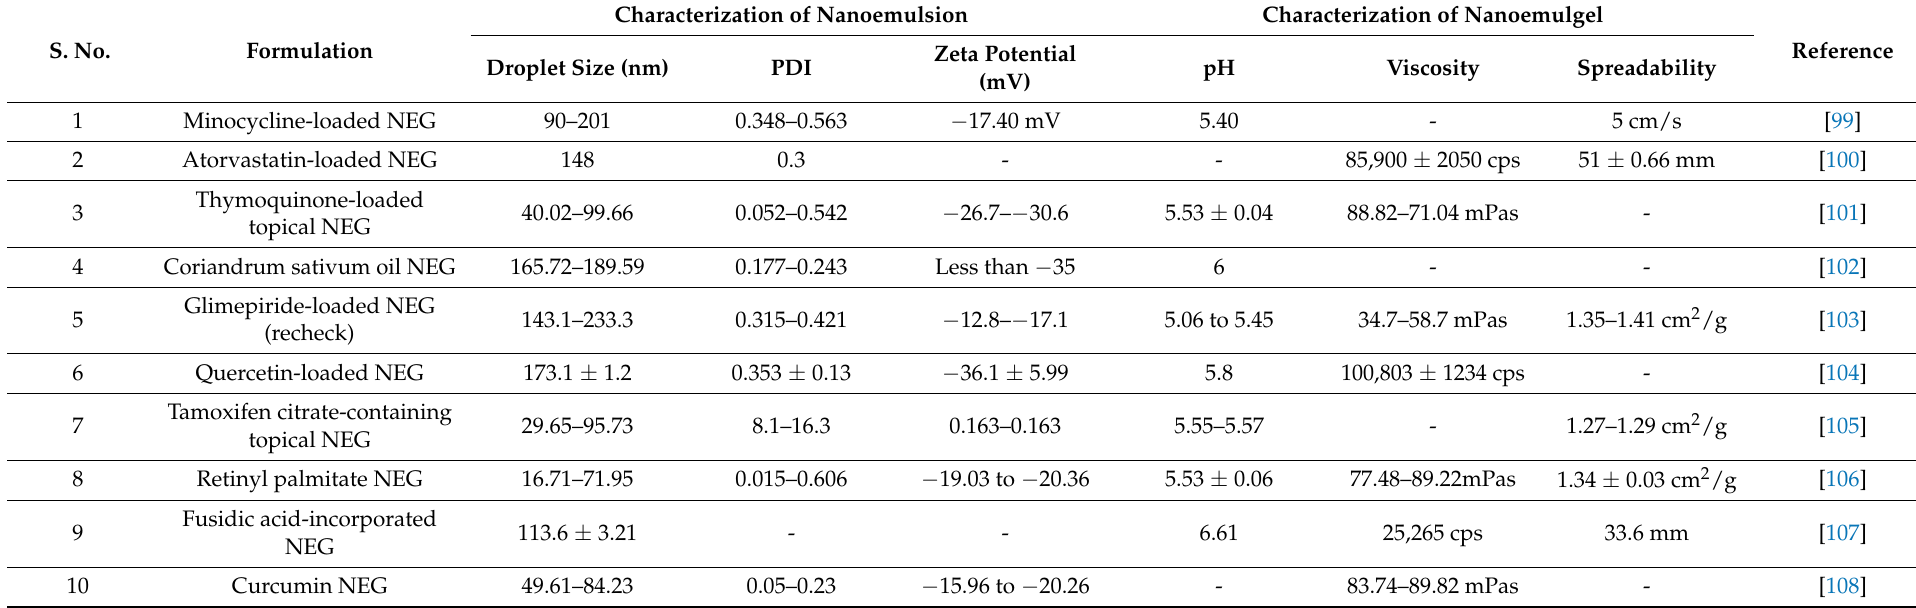
Table 1. Key evaluation parameters for the